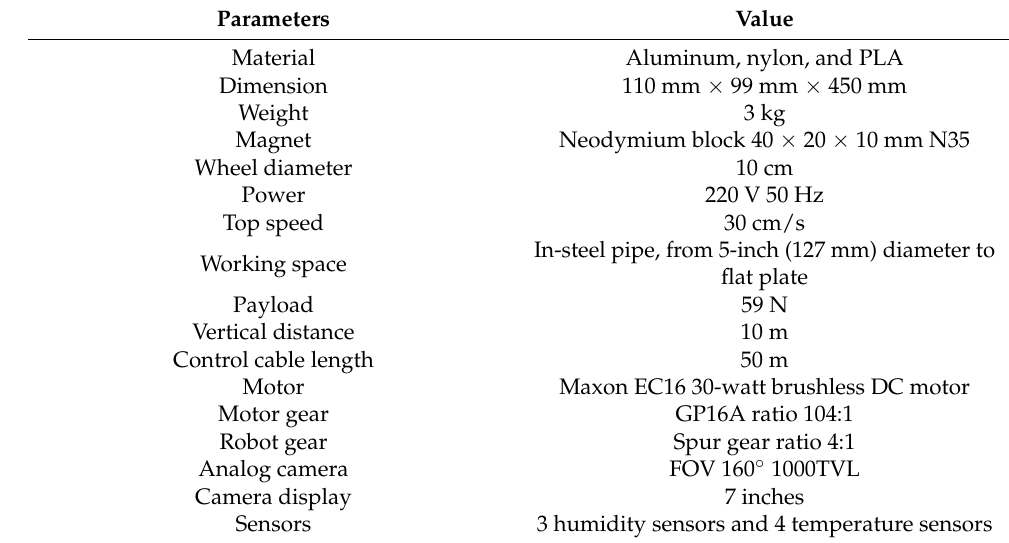
Table 3. The specifications of the prototype of the developed robot.